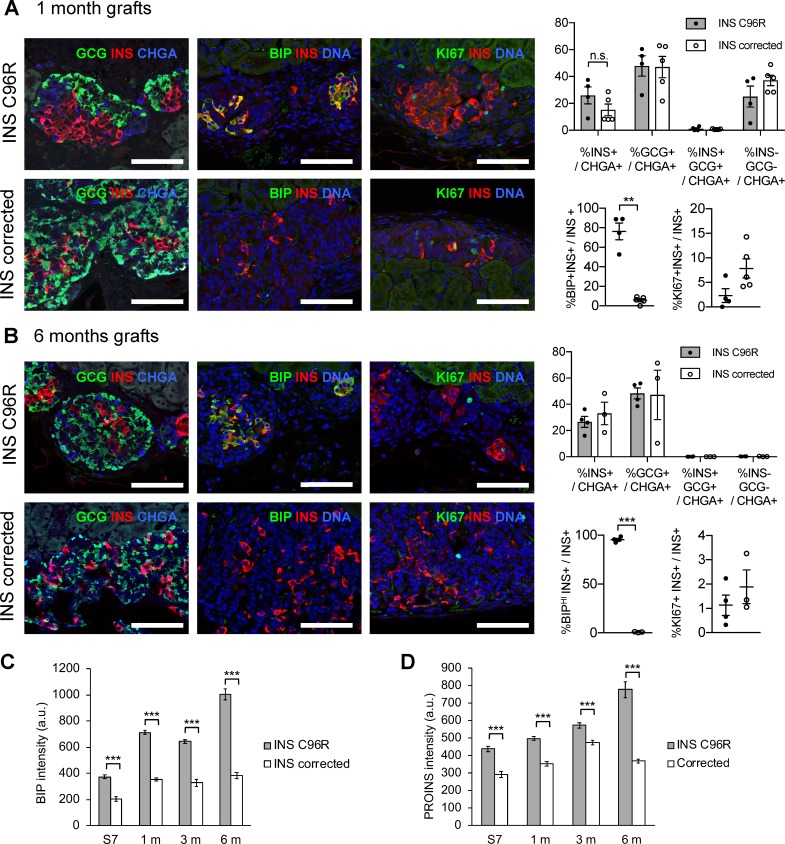
Increased ER-stress and reduced proliferation in 1 and 6–month grafts.(A) Immunohistochemistry for endocrine hormones GCG, INS and CHGA, ER-stress marker BIP and proliferation marker KI67 in 1 month old grafts, and its quantification (n = 4–5; n.s. = not significant using Mann-Whitney test; **p < 0.01 using Student’s t test with Welch’s correction). (B) Immunohistochemistry for endocrine hormones GCG, INS and CHGA, ER-stress marker BIP and proliferation marker KI67 in 6 months old grafts, and its quantification. Data represent mean ± SEM, n = 3–4 independent grafts per cell genotype. Scale bars = 100 µm. (C–D) Quantification of BIP and PROINS staining mean fluorescence intensity per individual INS+ cell across genotypes and timepoints. ***p < 0.001, Student’s t test. Data represent mean ± SEM, n = 44–268, a.u. = arbitrary units.